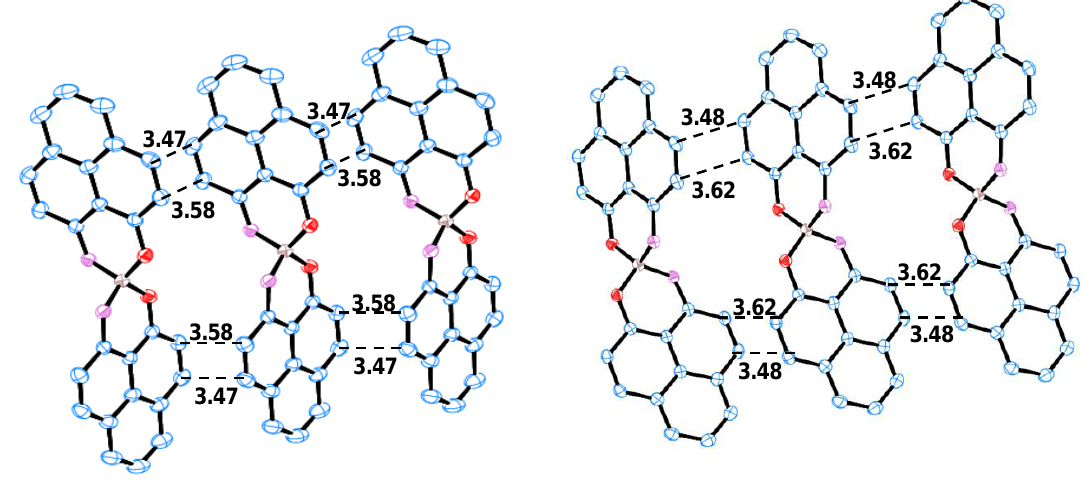
Figure 5. Packing along b axis showing one dimensional (1D) π-step structure and the closest intermolecular contacts for 7 ( left ) [48] and 11 ( right ); the four equivalent spin bearing C···C interactions per molecule are of length 3.47 Å ( 7 ) and 3.48 Å ( 11 ). Reprinted with permission from [48] Copyright 2004, American Chemical Society.